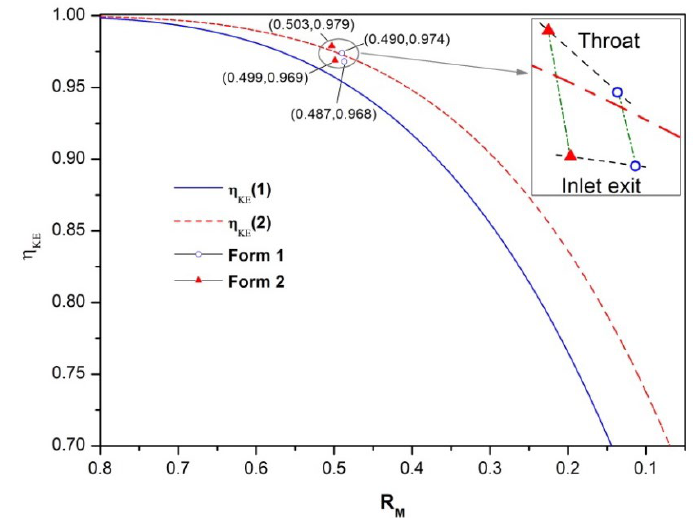
Figure 4. Compression efficiency of the two forms under the design conditions (M = 6.0, H = 24 km).